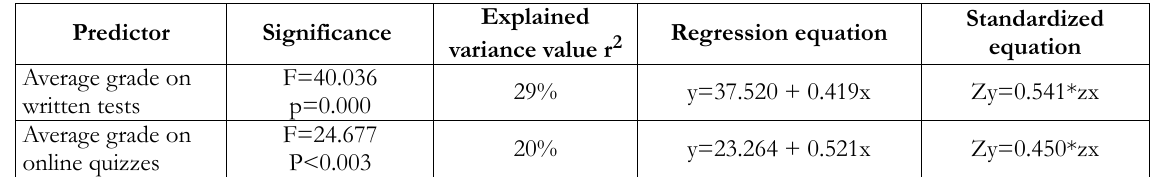
Table 1. Regression models for predictors of the final